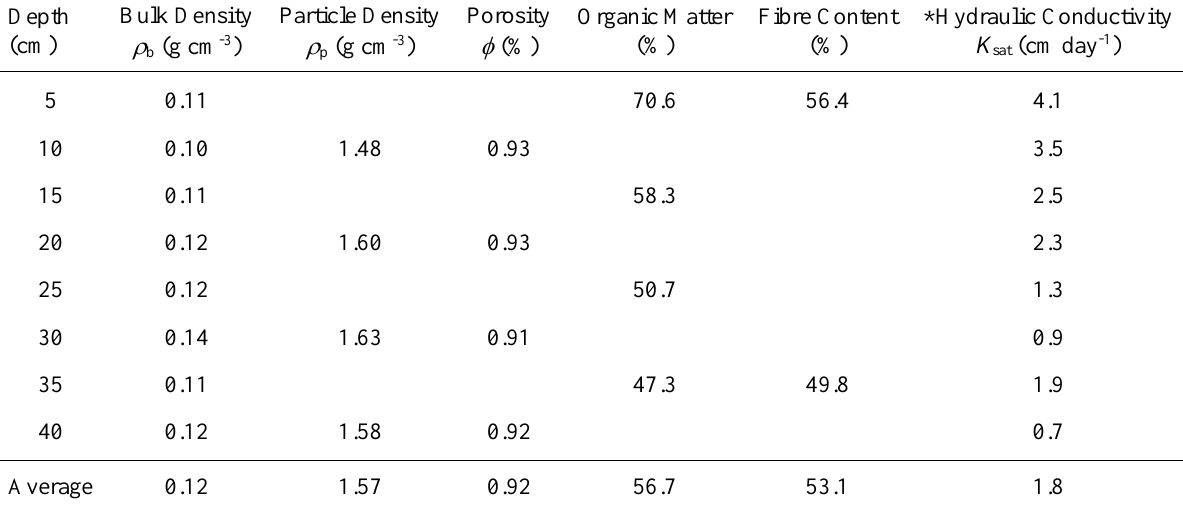
Table 1. Gyttja properties (mean of 3 samples) Note: *one set of three gyttja cores was used to determine bulk density, porosity and organic matter content; a separate set of three cores was used to determine fibre content, hydraulic conductivity and particle density. Hydraulic conductivity was calculated as a geometric mean.